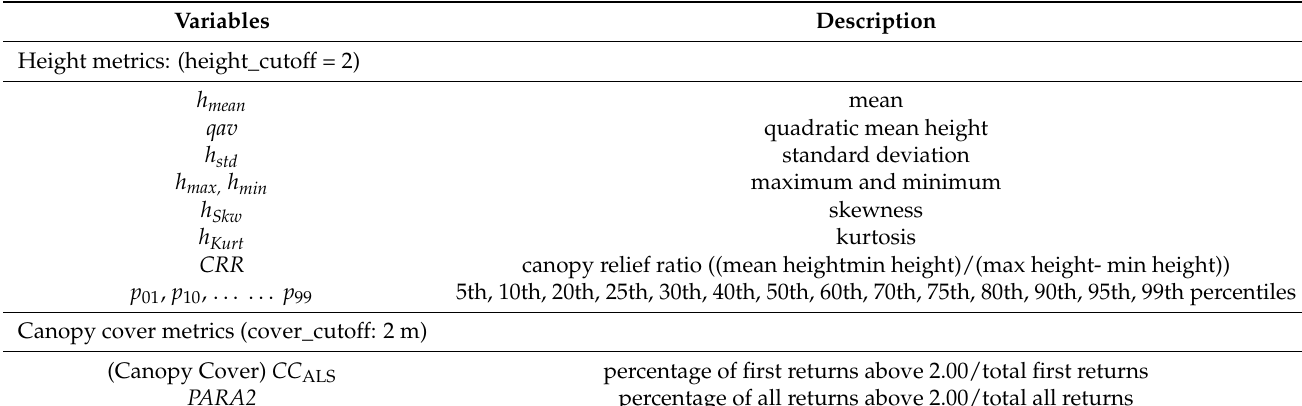
Table 1. Set of statistics derived from ALS data computed for the ground-footprint location of GEDI laser beams across the training area.